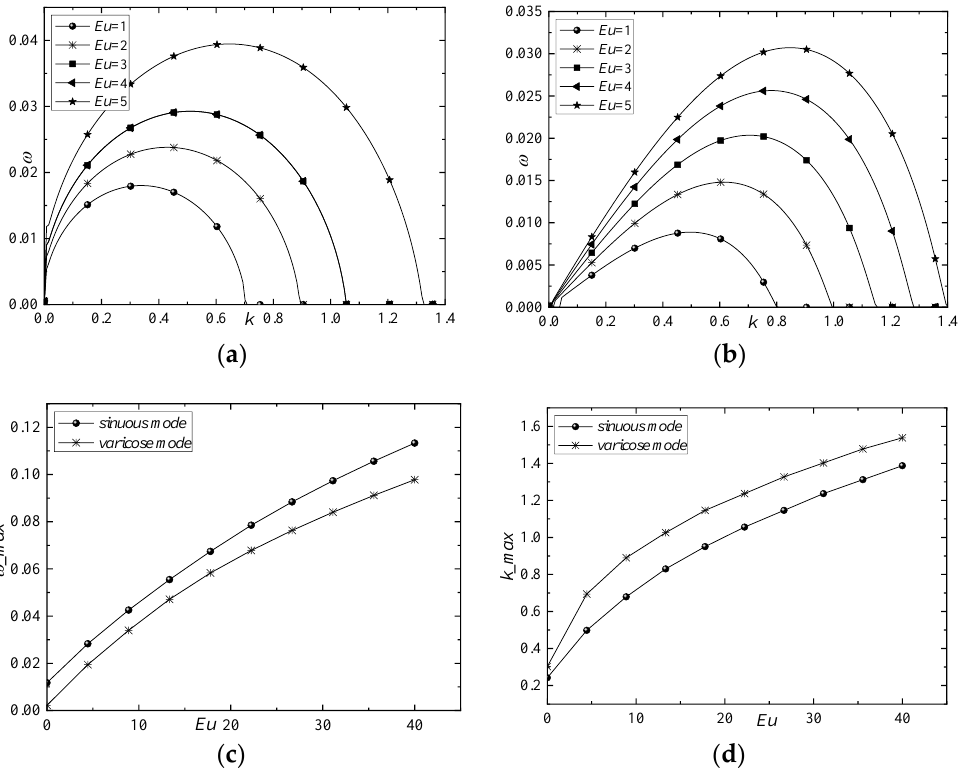
Figure 4. Effects of Eu on ( a ) sheet instability for sinuous mode, ( b ) sheet instability for varicose mode, ( c ) maximum growth rate, and ( d ) dominant wavenumber.